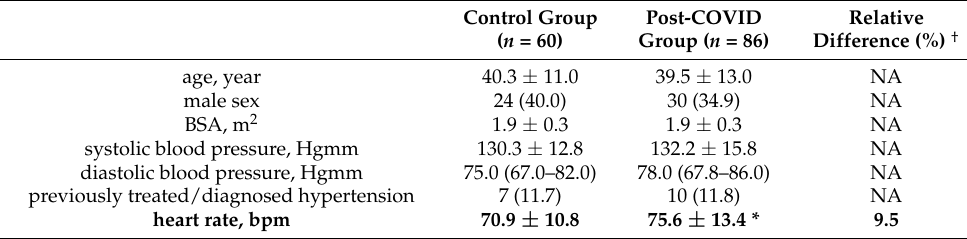
Table 1. Baseline clinical characteristics of study